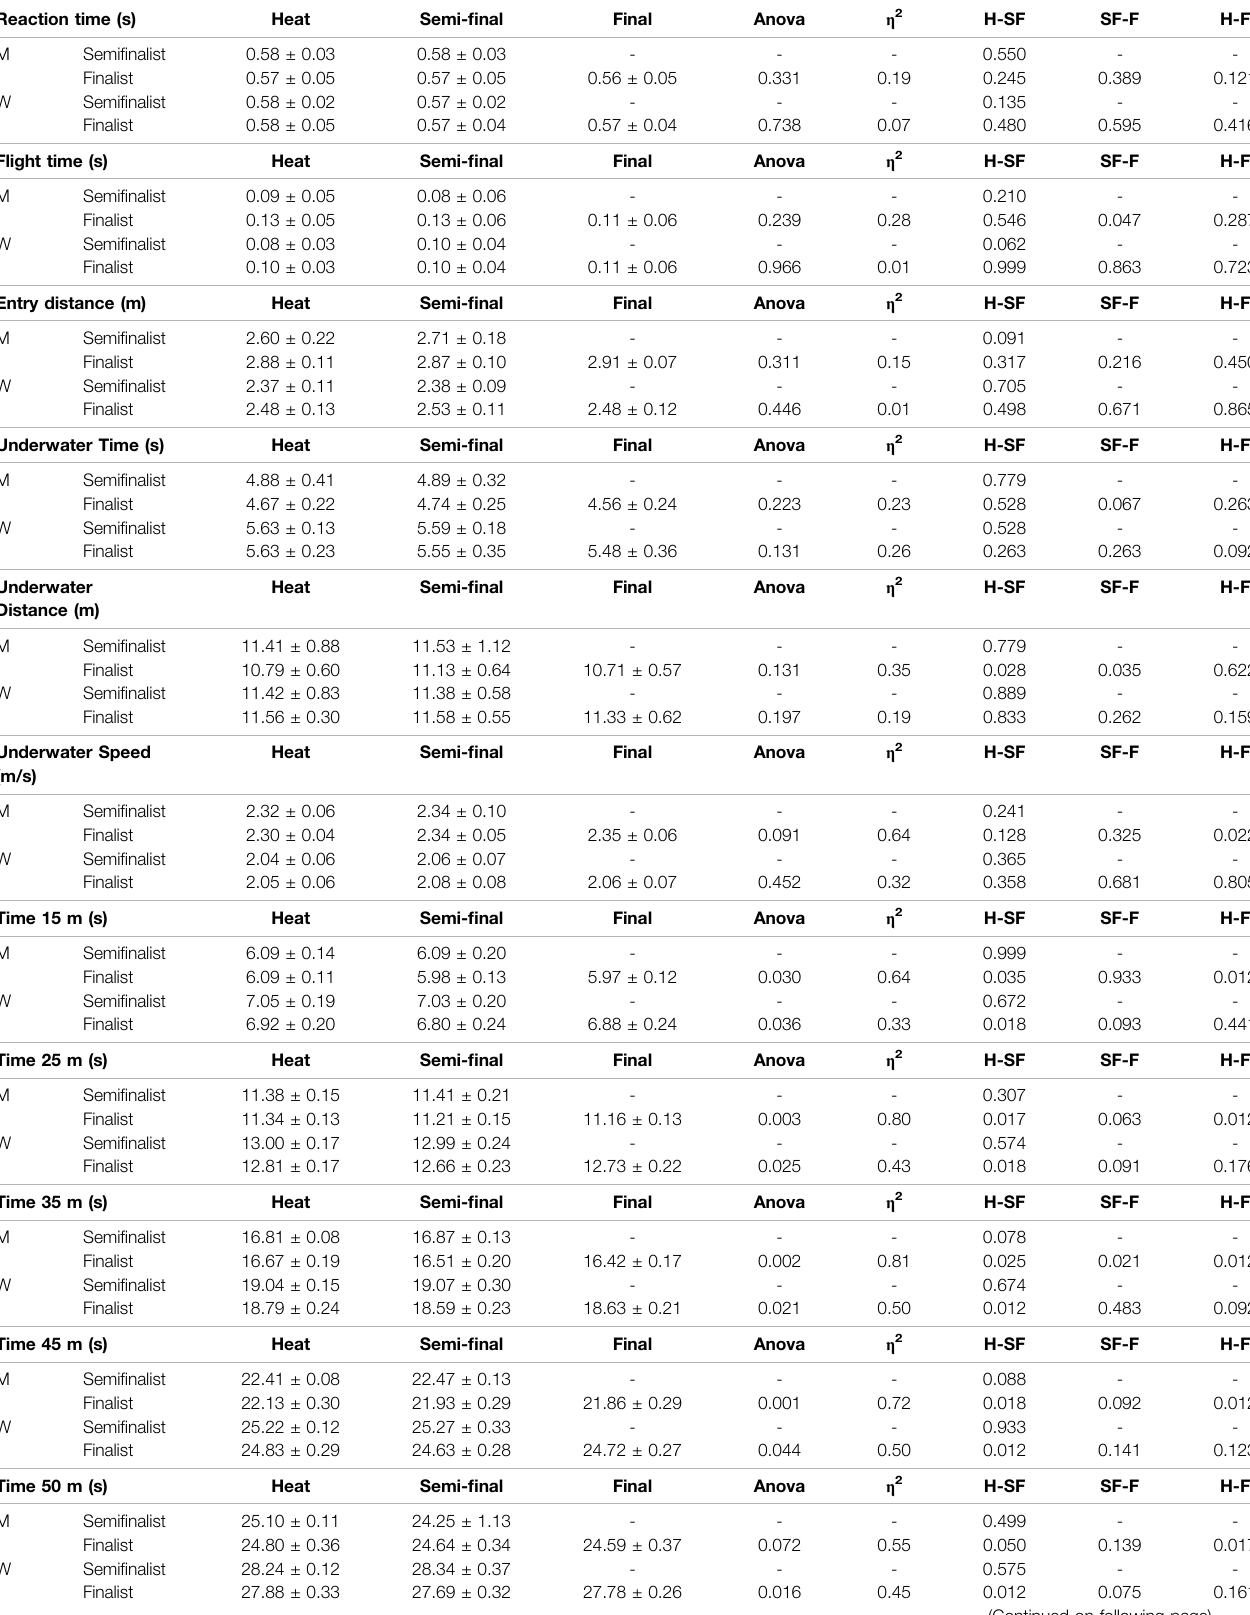
TABLE 2 | Backstroke performance variables ’ results, p values, and effect sizes ( η 2 ) between the different three rounds. Men (M); Women (W) (LEN European Senior Championships 2021). Reaction time